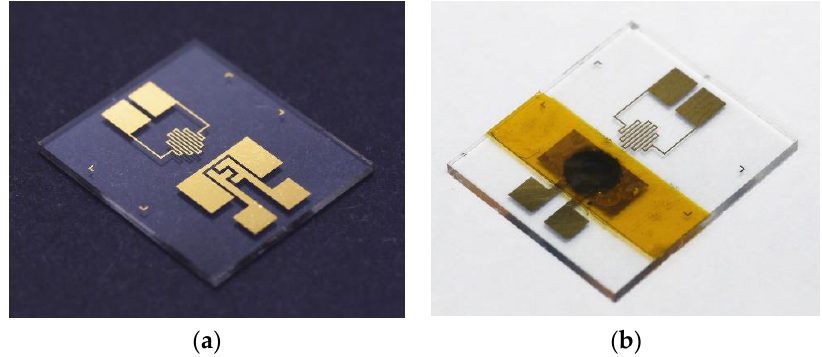
Figure 5. Fabrication results. ( a ) The bottom layer. ( b ) Assembled DC-driven thermal oscillator.